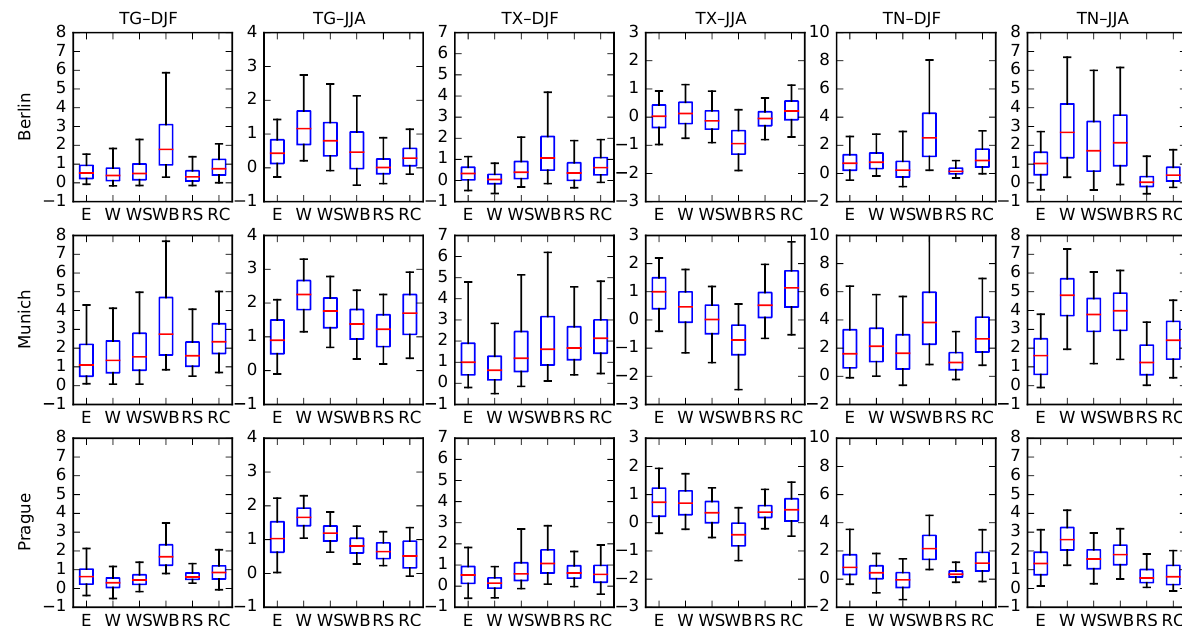
Figure 5. Distributions of temperature differences ( ◦ C) between city centres and their surroundings in winter and summer seasons given by station data (E), WRF–BULK (W), WRF–SLUCM (WS), WRF–BEP + BEM (WB), RegCM–SLUCM (RS) and RegCM–CLM4.5 (RC) model simulations. TG denotes temperature means; similarly, TX and TN stand for maxima and minima, respectively. Whiskers indicate 5th and 95th